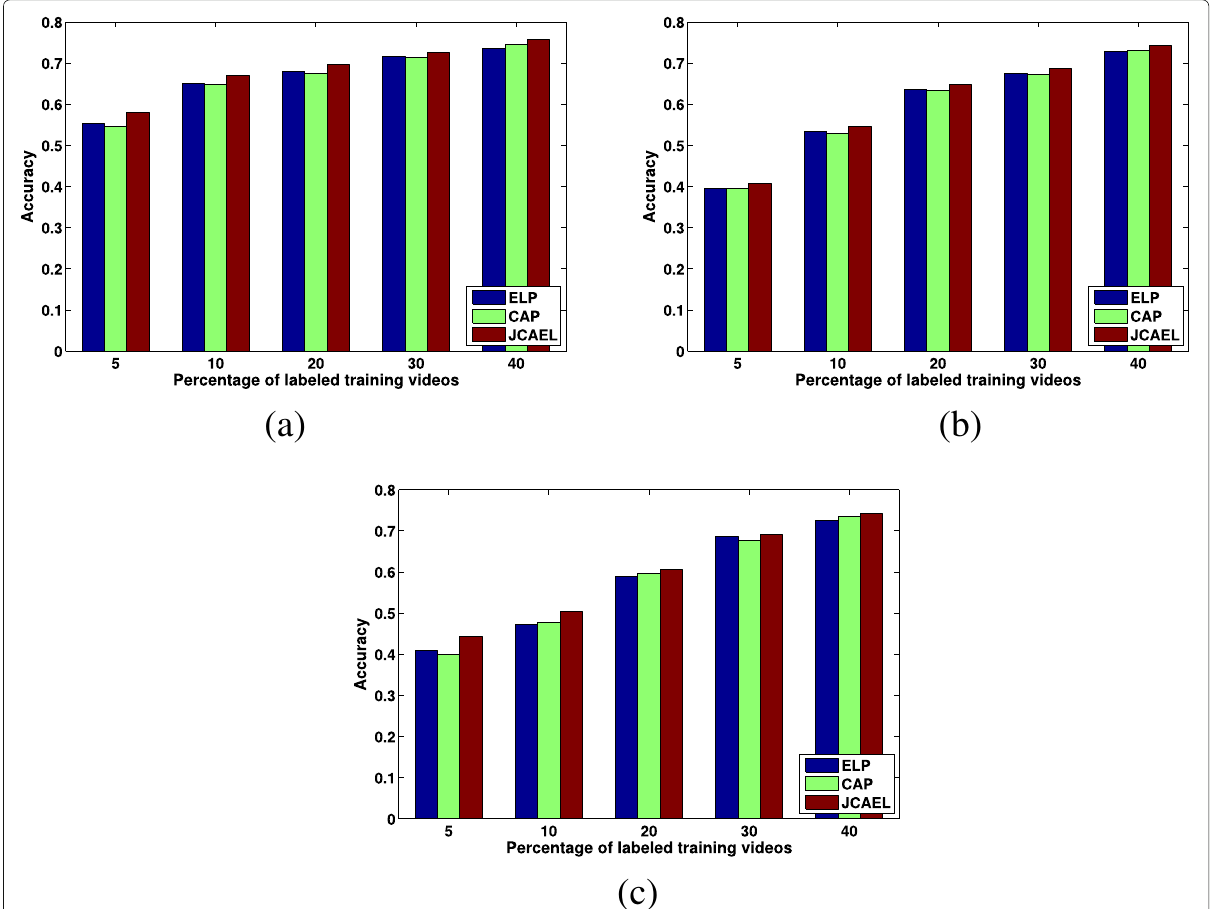
Fig. 7 Classification results of different methods on UCF ← PPMI4 when the ratios of labeled video data are different. a LMCSVM as classifier. b LSR as classifier. c MCkNN as